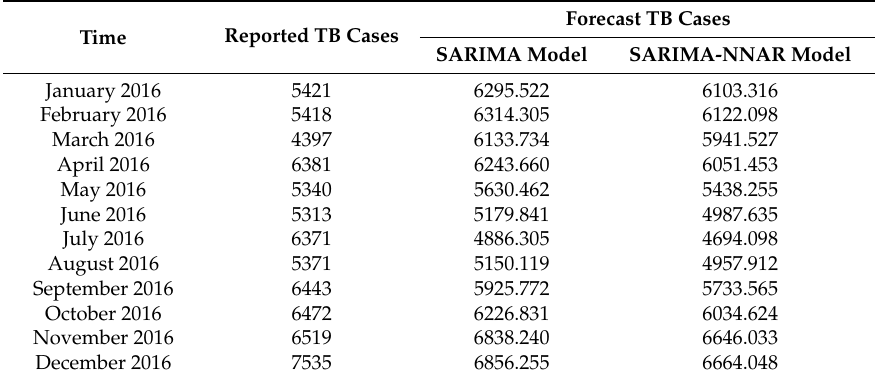
Table 3. Yearly reported and forecast of TB incidence cases for